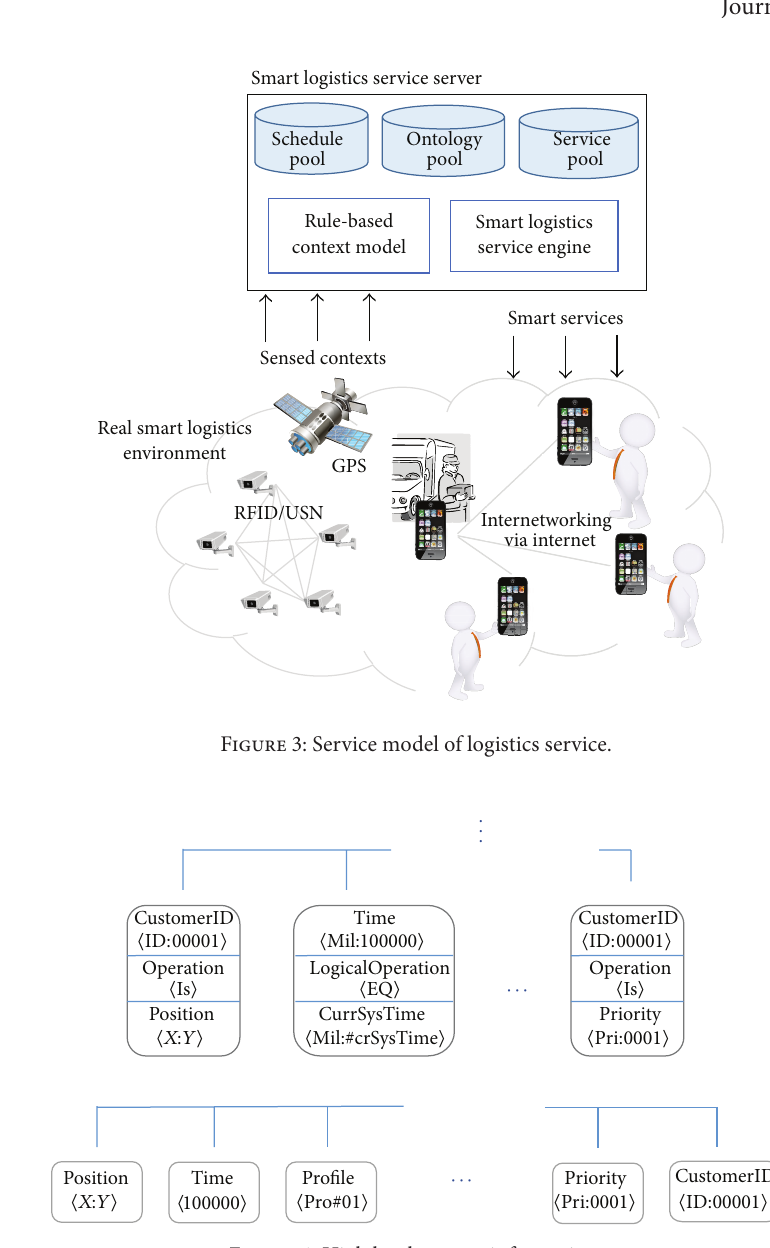
Figure 4: High level context